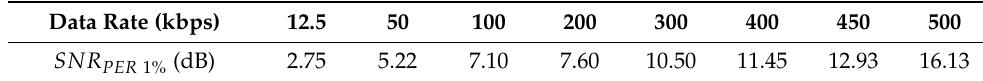
Table 4. SNR of each data rate under PER